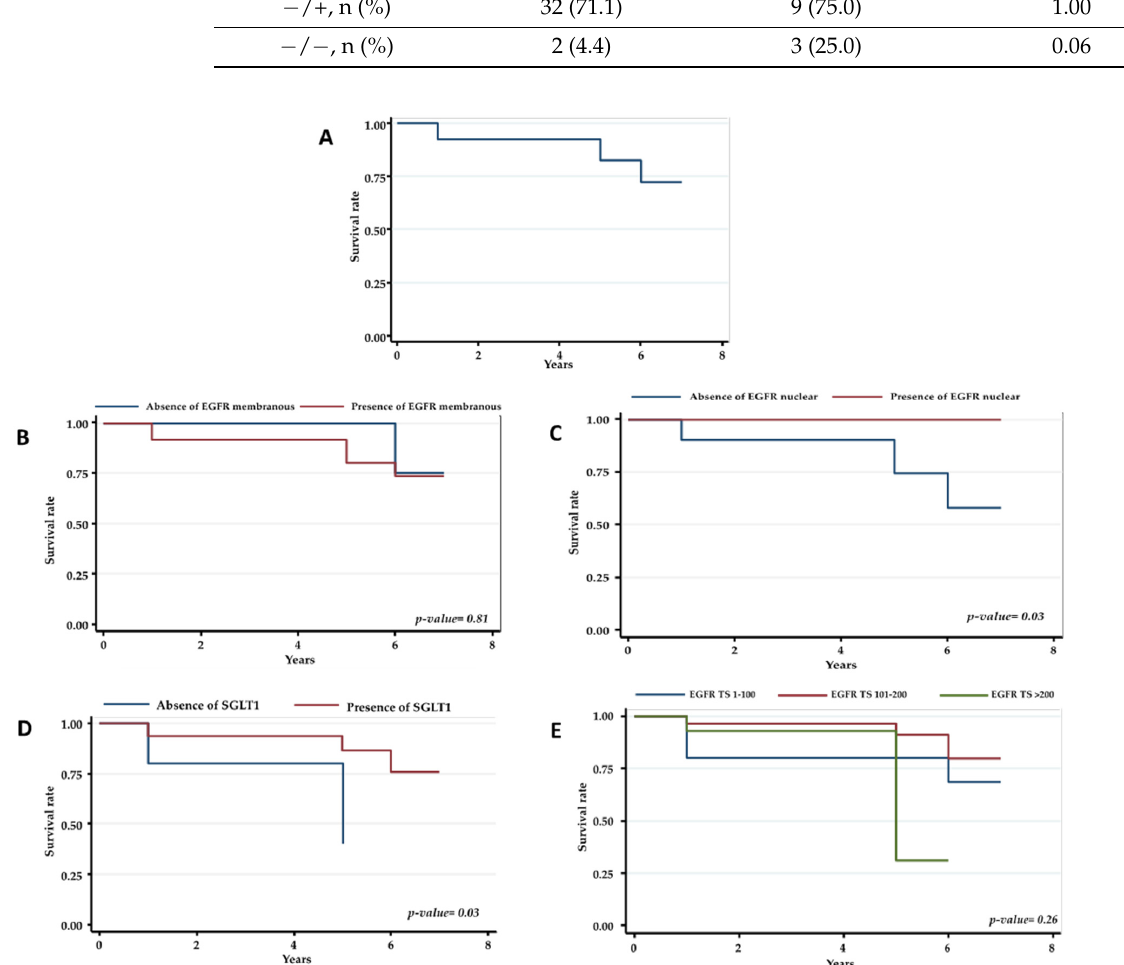
Figure 2. Kaplan–Meier curves for overall survival. ( A ) distribution of overall survival ( B ) overall survival according to absence/presence of immunostaining for membranous-cytoplasmic EGFR ( C ) overall survival according to three TS-EGFR groups, ( D ) overall survival according to absence/presence of immunostaining for nuclear EGFR, ( E ) overall survival according to absence/presence of immunostaining for SGLT1.